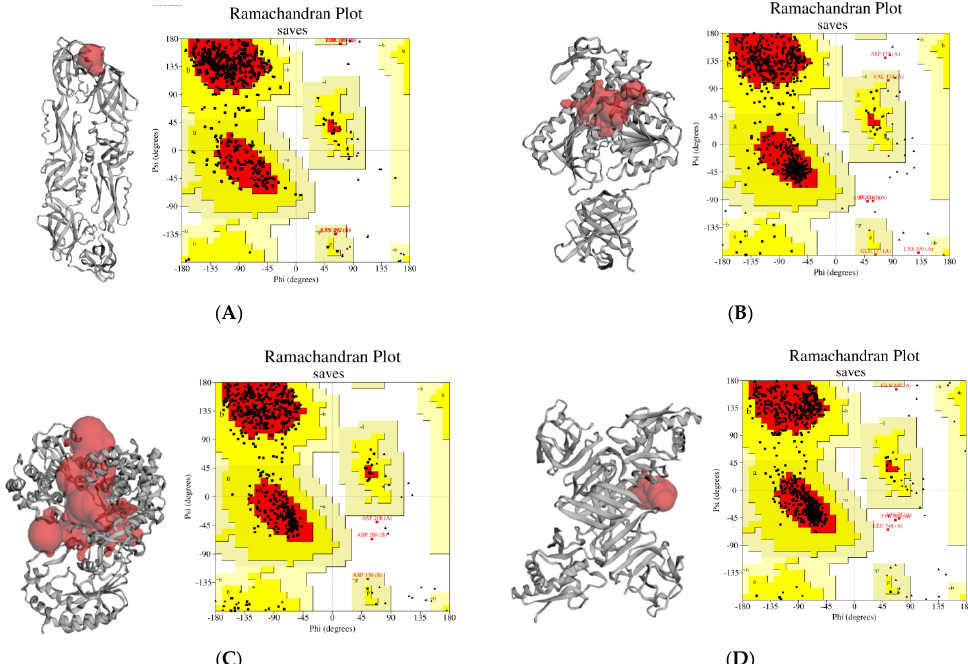
Figure 1. The estimated active sites, which make up the amino acids, are shown in the active site identification (red pocket) findings from the CASTp network and structure validation (by Procheck). ( A ) Viral envelope (E) protein (PDB ID: 1OKE); ( B ) serine protease (NS3) protein (PDB ID: 2VBC); ( C ) RNA-directed RNA polymerase (NS5) (PDB ID: 4V0Q); ( D ) non-structural protein 1(NS1) (PDB ID: 4O6B). [Some errors (letters in Ramachandran plot) are generated by automated software which can’t be changed